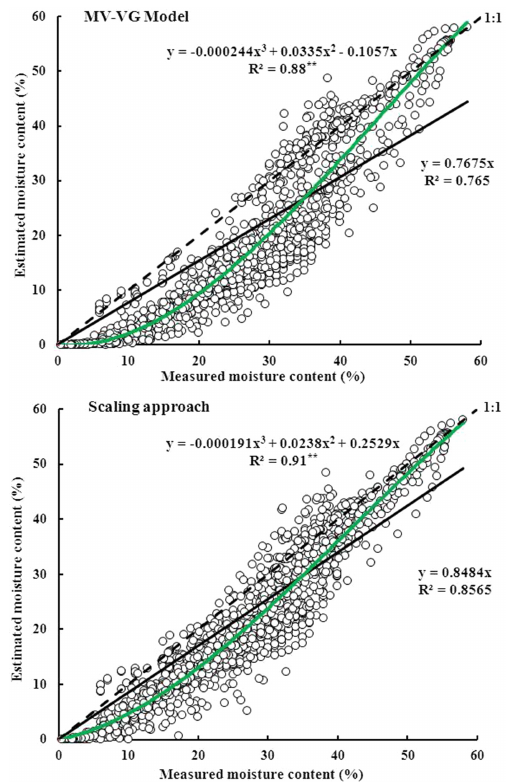
Figure 3. Comparisons of the measured and estimated moisture contents for 82 selected soils using the MV–VG model (Eq. 9) and scaling approach (Eq. 12). Dashed lines: the 1:1 line. Solid lines: linear-regression line. Solid green line: nonlinear-regression